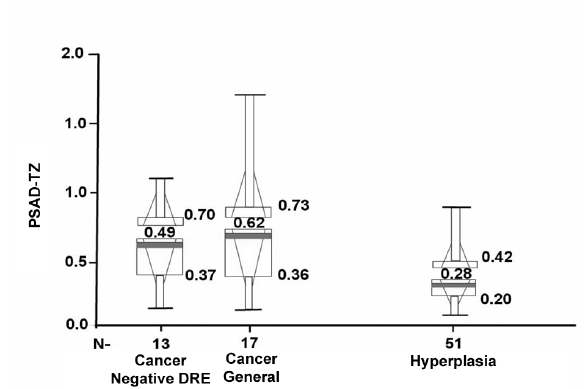
Figure 3 – “Box Plot” graphs showing the distribution of mean and median PSADTZ values for cancer (n = 17) and hyperpla- sia (n = 51) in the general and negative digital rectal examina- tion (n = 13) groups. PSAD-ZT = PSA density in the transition